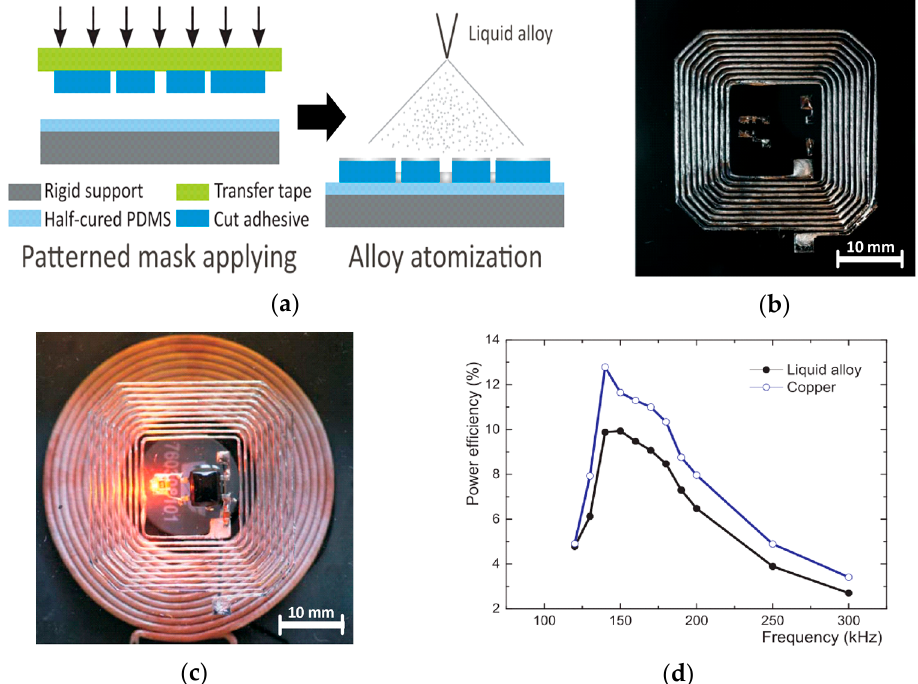
Figure 7. ( a ) Schematic illustrating resonant coil antenna fabrication using PDMS patterning and LM atomization spray; ( b ) fabricated resonant coil filled with liquid alloy; ( c ) resonant coil in operation; and ( d ) comparison of power transfer efficiency of resonant coil antenna with a standard copper coil [44].